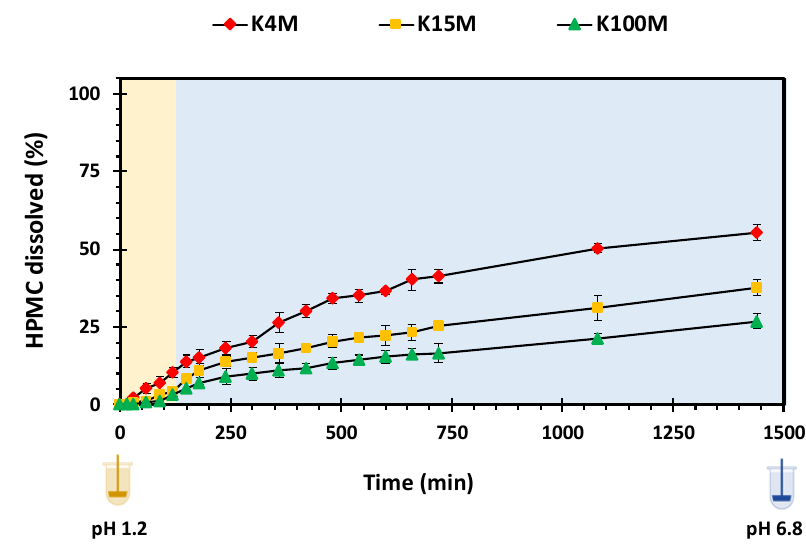
Figure 8. HPMC dissolution vs. time profile of 3D printed HPMC matrix tablets.